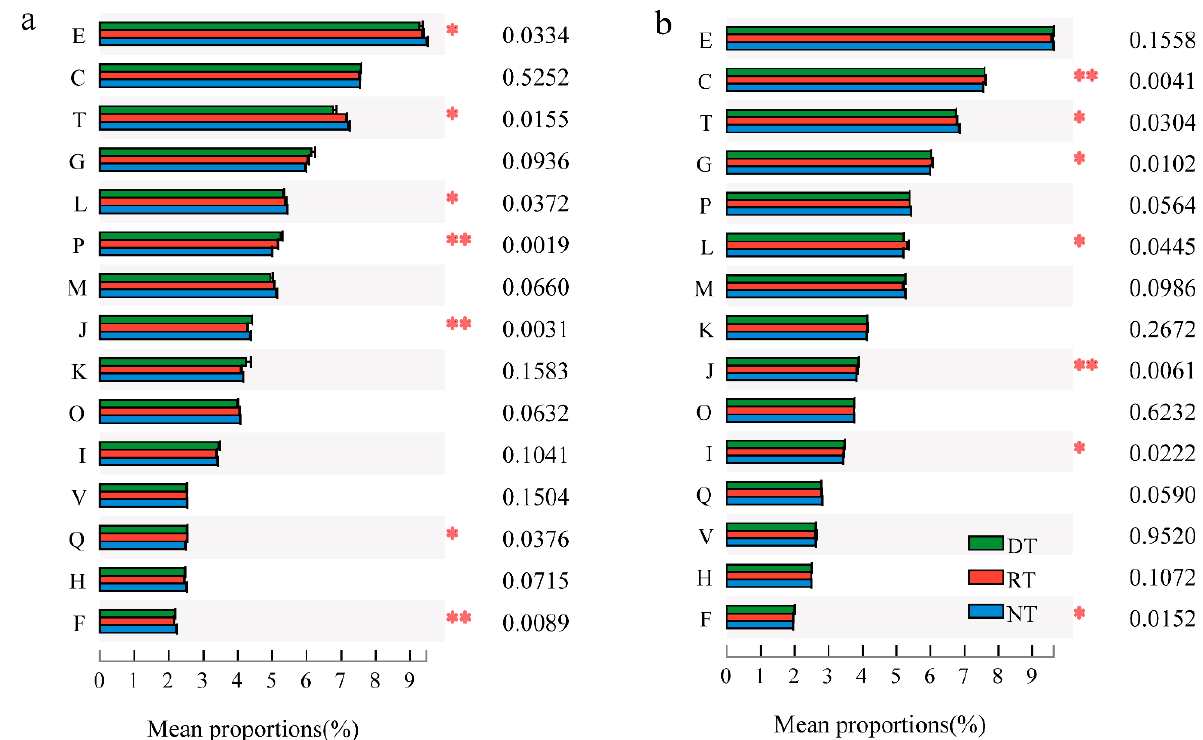
Figure 3. Analyses of function-related differences focused on clusters of orthologous groups of proteins (COG) using the evolutionary genealogy of genes: non-supervised orthologous groups (eggNOG) represented the top 15 of all COGs under different treatments in the ( a ) wheat and ( b ) maize seasons. E, Amino acid transport and metabolism; C, Energy production and conversion; G, Carbohydrate transport and metabolism; T, Signal transduction mechanisms; L, Replication, recombination and repair; P, Inorganic ion transport and metabolism; M, Cell wall/membrane/envelope biogenesis; J, Translation, ribosomal structure, and biogenesis; K, Transcription; O, Post-translational modification, protein turnover, and chaperones; I, Lipid transport and metabolism; V, Defense mechanisms; Q, Secondary metabolite biosynthesis, transport and catabolism; H, Coenzyme transport and metabolism; F, Nucleotide transport and metabolism. *, ** mean significant difference among treatments at p = 0.05, 0.01, respectively.